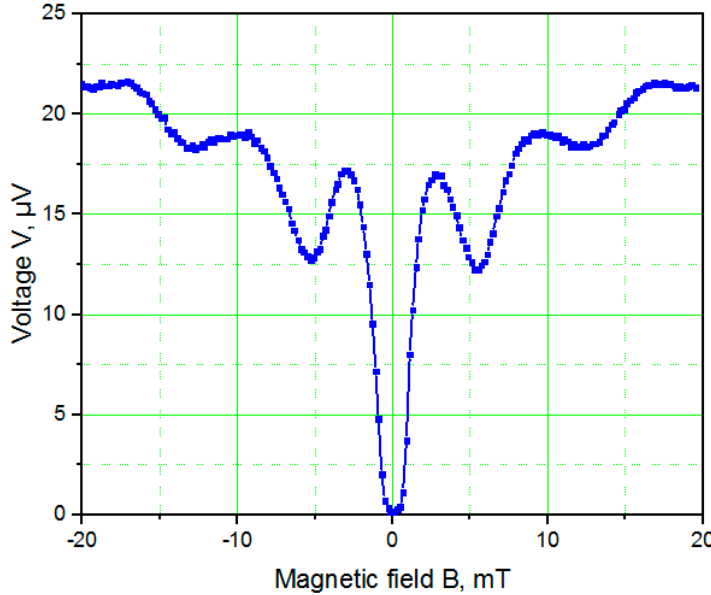
Figure 9. V(B) dependence of the TiN nanoSQUID measured at 4.2 K. Figure 9. V ( B ) dependence of the TiN nanoSQUID measured at 4.2